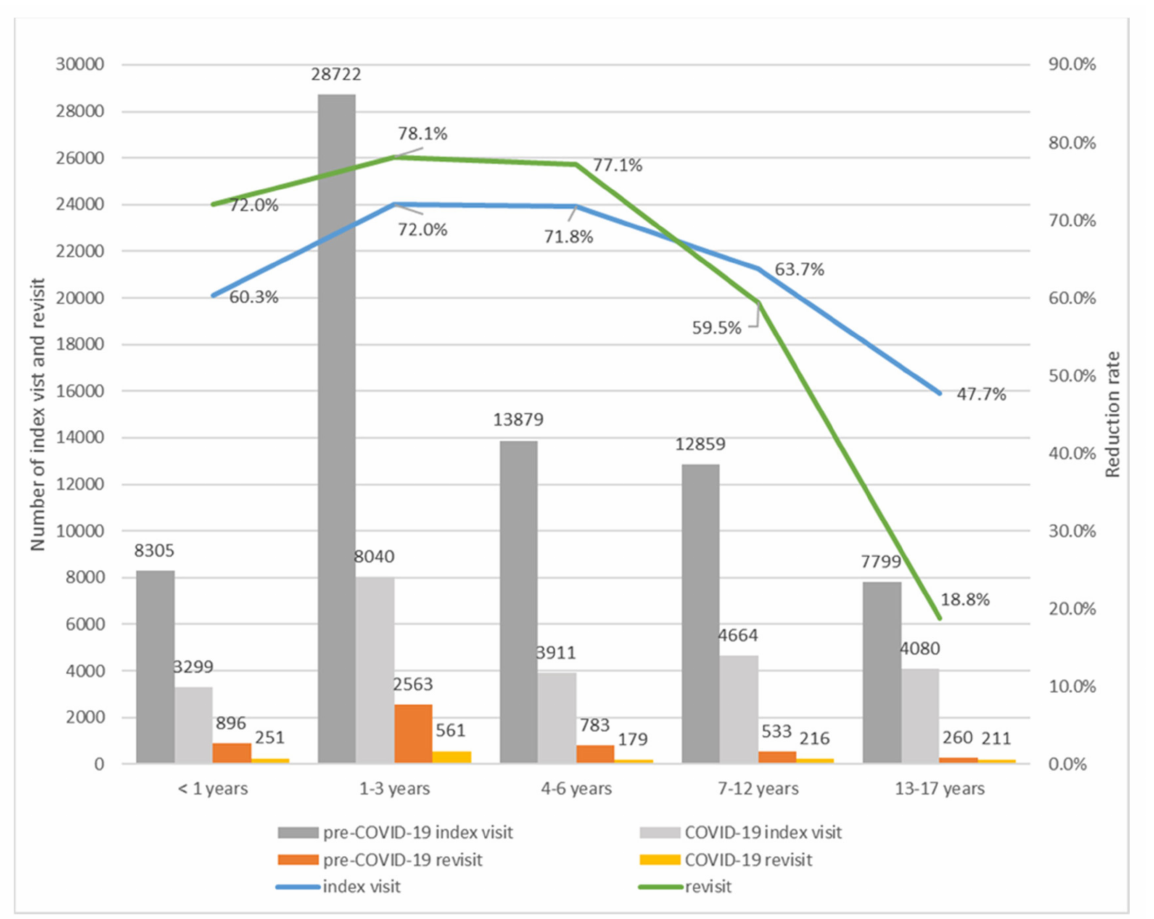
Figure 3. Reduction rates of index visits and